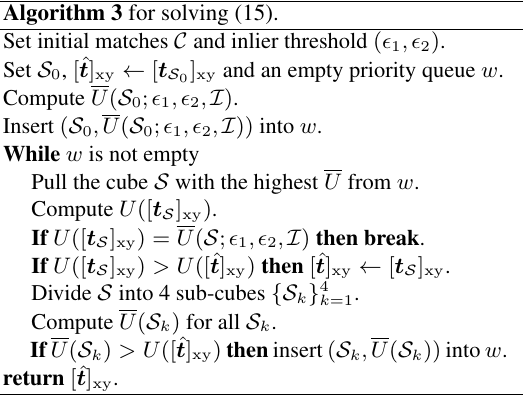
Algorithm 3 for solving (15).